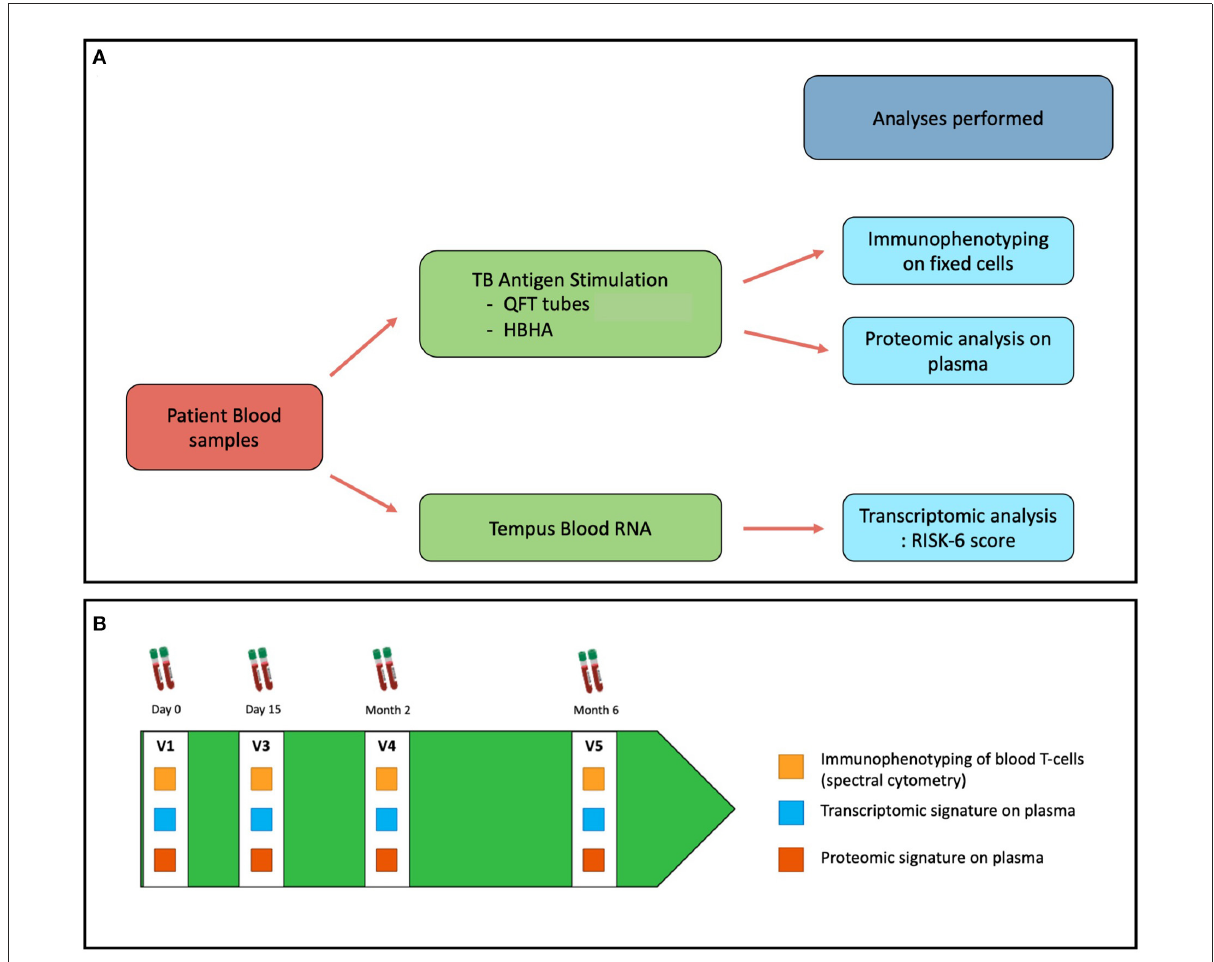
blood sampling will be collected at each visit for biomarker assessment as described in Figure